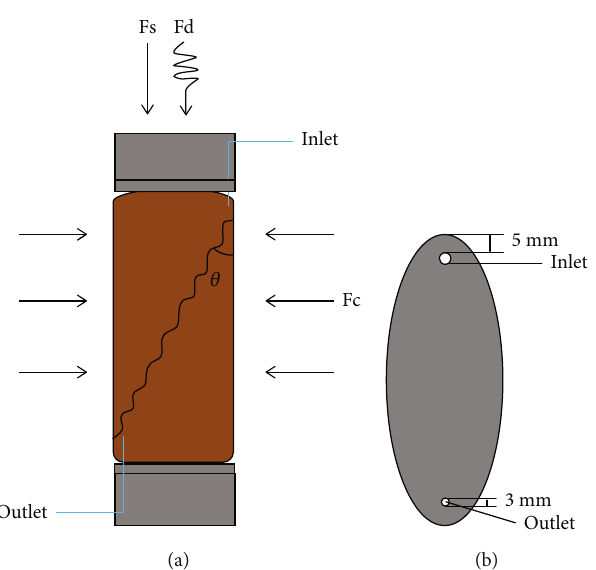
Figure 1: (a) Sketch of fractured rock sample and (b) a rough fracture with boreholes for fl uid fl